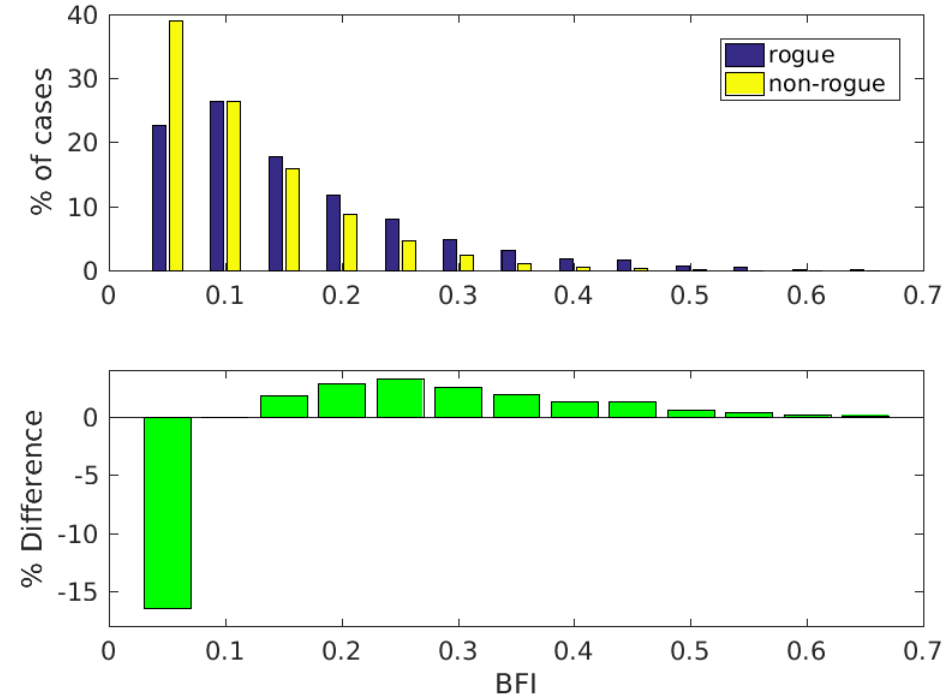
Figure 5. Comparison of BFI probability distributions for rogue and non-rogue datasets (all buoy locations combined). Top panel : Percentage of cases in selected BFI ranges for each dataset (bins centered from 0.05 to 0.65 with 0.05 width). Bottom panel : Difference in percentage of cases in selected BFI ranges. Positive values indicate a greater percentage of rogue wave events than non-rogue events for the specified BFI bin. (Values beyond 0.65 were too small to be visible on plots).